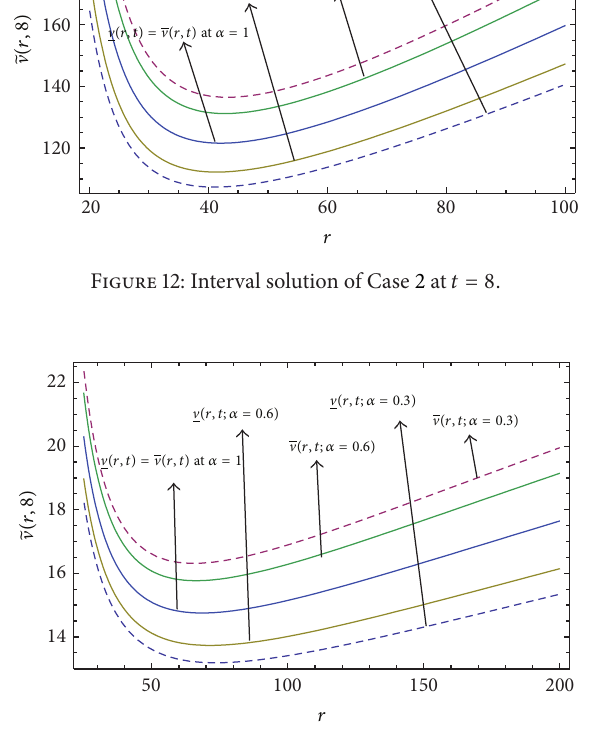
Figure 13: Interval solution of Case 3 at 𝑡 = 8 .